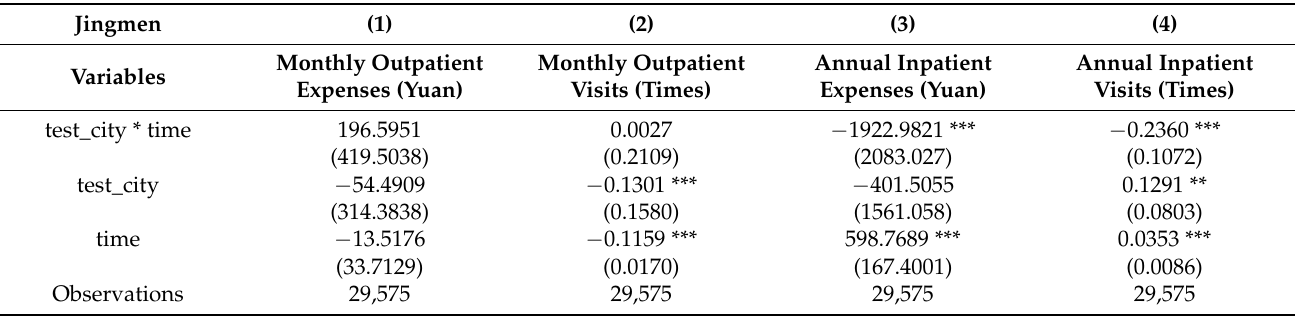
Table 2. Results of DID with the raw